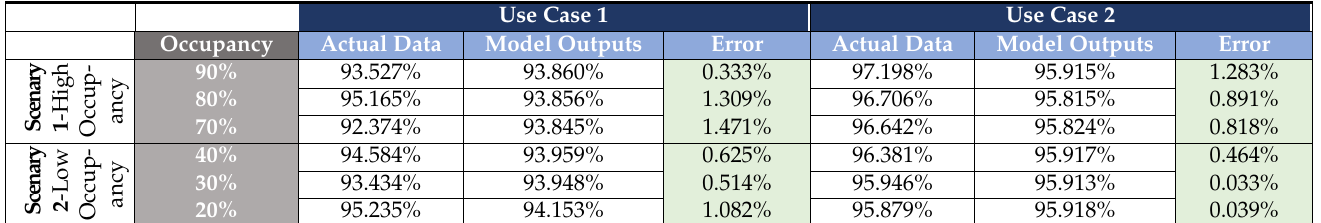
Table 2. Bayesian Network validation.